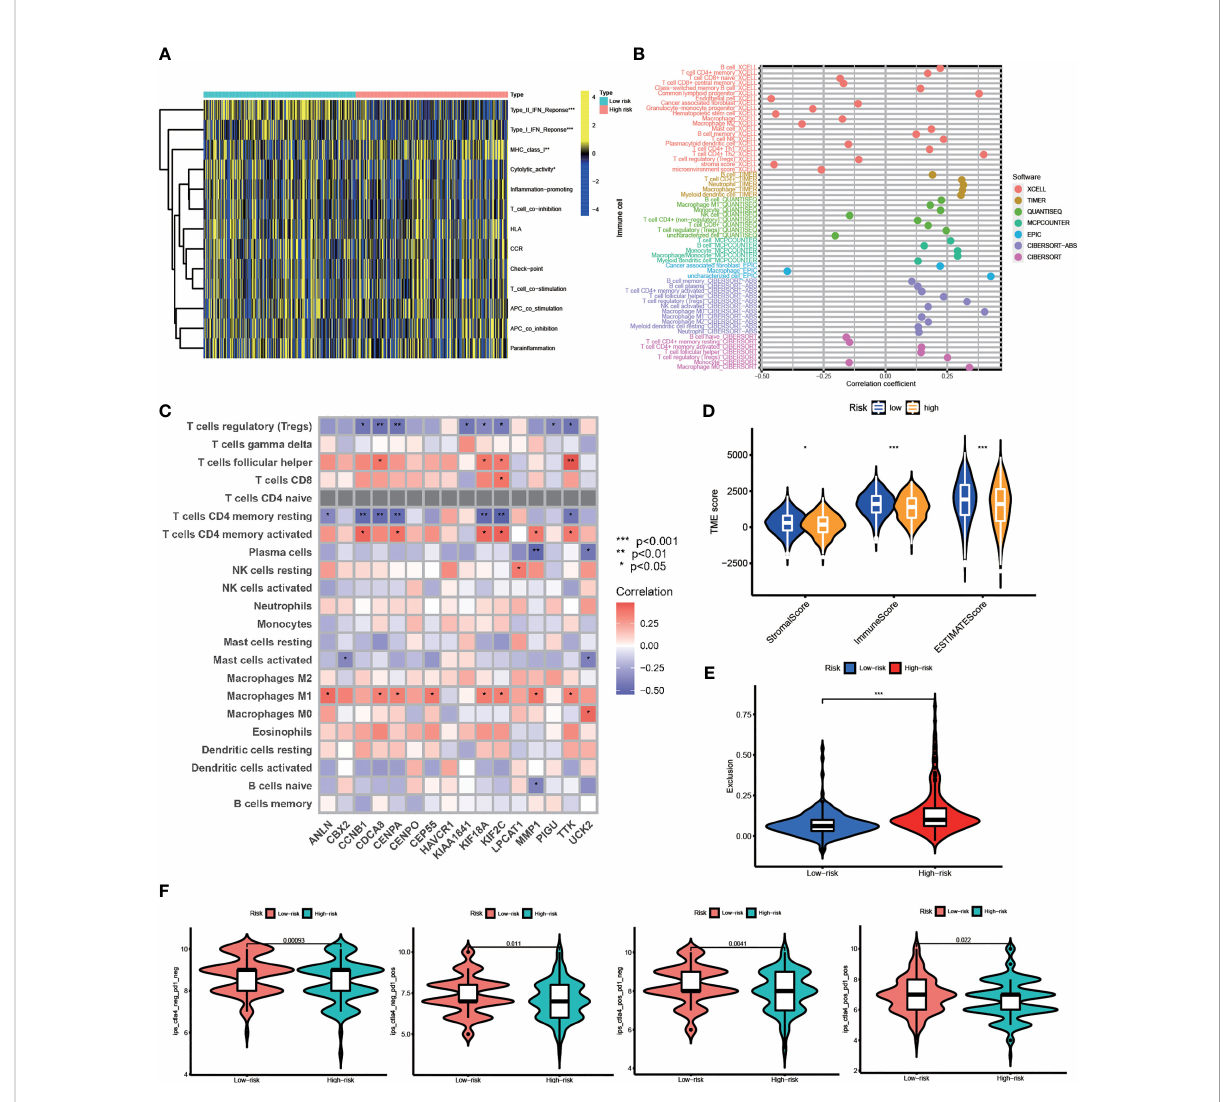
FIGURE 6 TME In fi ltration and Immunotherapy. (A) Heatmap of the distribution of 13 types of immune function pathways between two groups. (B) Immune cell in fi ltration analysis based on different algorithms. (C) Correlation between immune-related cells and 16 genes. (D) TME score, including Stromal score, Immune score and Estimates score. (E) Exclusion score calculated by TIDE algorithm. (F) Immunotherapy score between two groups (po, positive; neg, negative) (*p < 0.05, **p < 0.01, ***p <